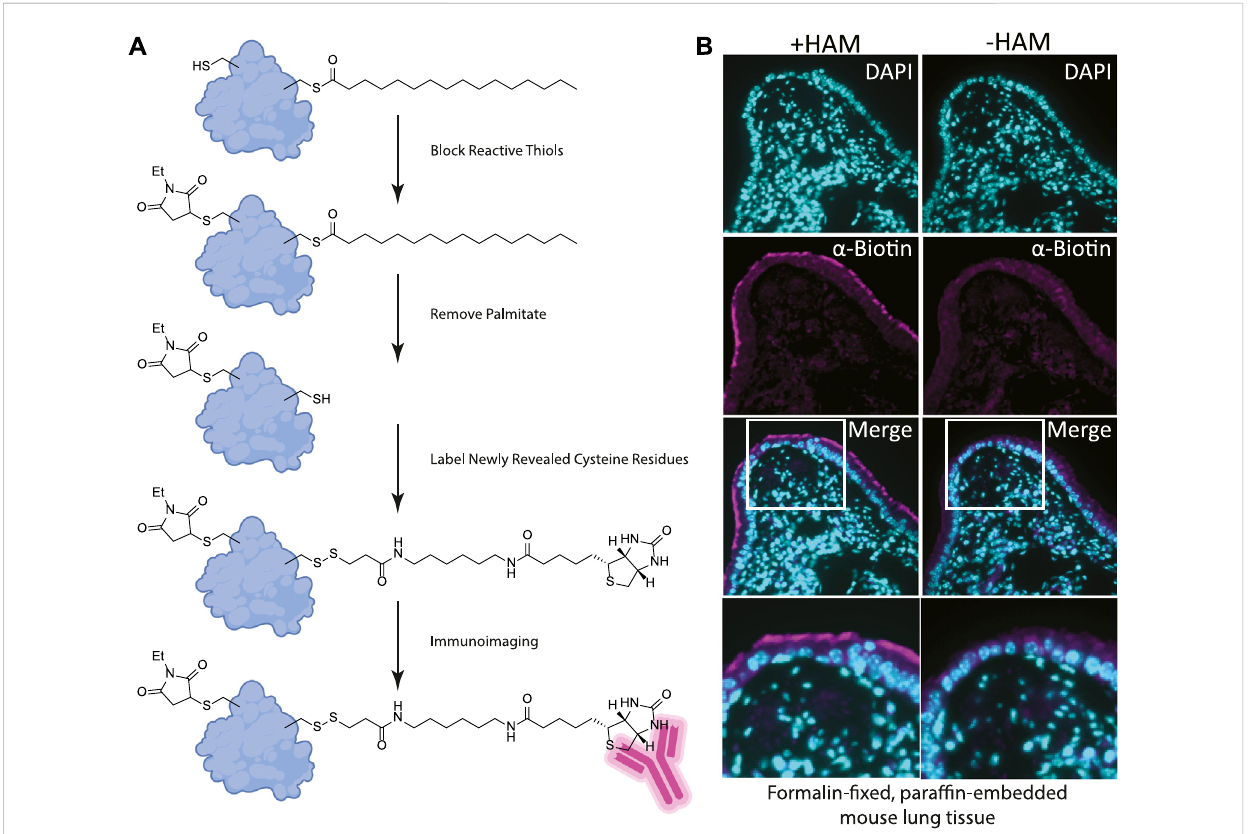
FIGURE 2 (A) Label free method for detecting palmitoylated proteins to be used on FFPE prepared tissues. 1) NEM treatment blocks free thiol groups on all proteins. 2, 3) Hydroxylamine (HAM) treatment removes palmitate and biotin-HPDP reacts with the revealed thiol. As a negative control HAM is omitted, but biotin-HPDP is still added. 4) The biotin is recognized with an anti-biotin antibody and detected with a fl uorescently conjugated secondary antibody. (B) FFPE tissue sections of mouse lung airway. The hydroxylamine treated (+HAM) samples reveal anti-biotin antibody labelling at the apical surface of the airway cells (magenta). In an adjacent section of the same sample where hydroxylamine (HAM-) has been omitted the labeling is absent. DNA is stained with DAPI